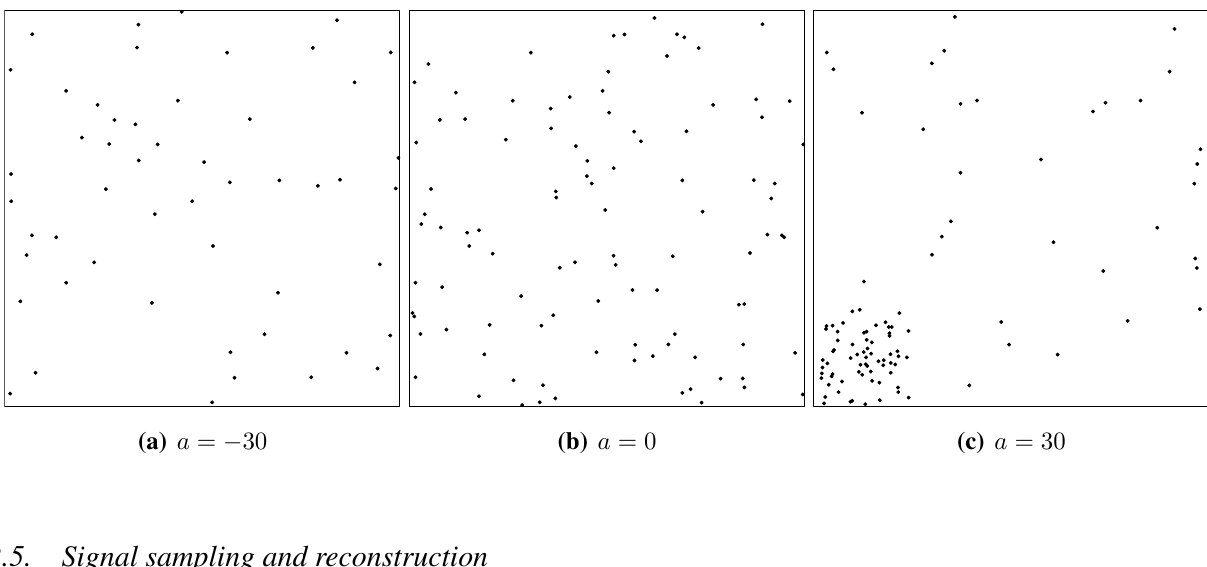
Figure 3. Samples of 100 spatial point